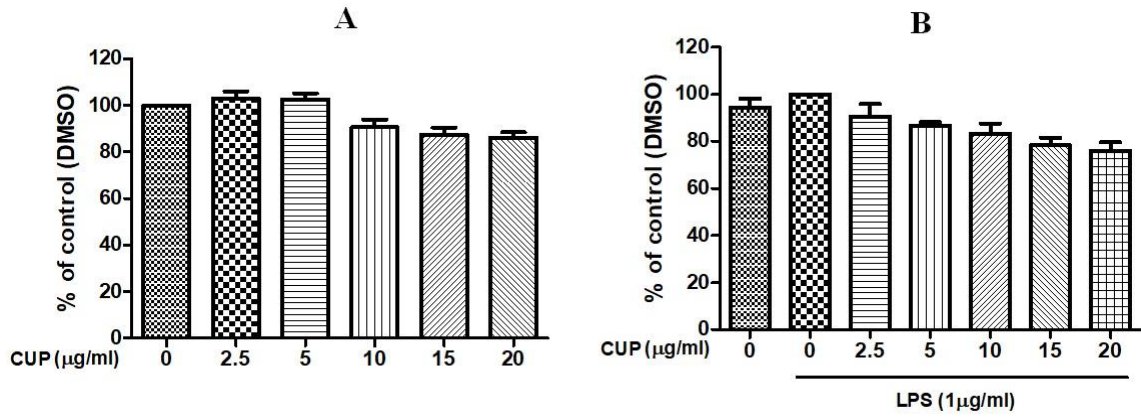
Figure 3. Cytotoxic effect of Citrus unshiu peel (CUP) flavonoids on RAW264.7 cells. Different concentrations of CUP (0, 2.5, 5, 10, 15, and 20 µ g/mL) were used for cell treatment for 24 h, with or without 1-h pre-incubation of lipopolysaccharide (LPS) (1 µ g/mL). Cell viability was measured with the MTT assay. ( A ) Cell viability of non-LPS-stimulated RAW264.7 cells after the treatment with CUP flavonoids at different concentrations. ( B ) Cell viability of LPS-stimulated RAW264.7 cells after the treatment with CUP flavonoids at different concentrations. Note: Data are the mean ± SEM of experiments in triplicate (n = 3).